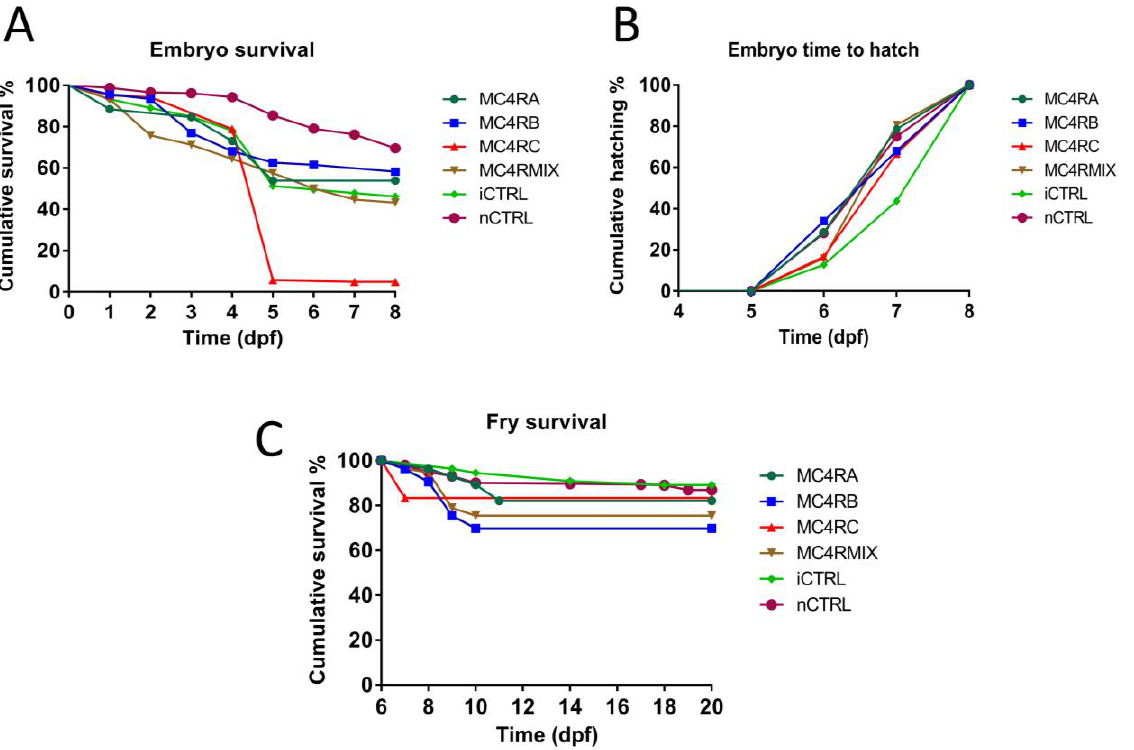
Figure 5. Embryo survival, hatchability, and fry survival curves of channel catfish, Ictalurus punctatus , embryos from the Kansas random strain microinjected at the one-cell stage with sgRNAs/Cas9 protein targeting the melanocortin-4 receptor ( mc4r ) gene. Three gRNAs were microinjected individually (MC4RA, MC4RB, and MC4RC) or multiplexed (MC4RMIX). Two control treatments were used. Injected control embryos (iCTRL) were full-sib to the treatment groups and injected with the same solution and volume, but without sgRNA or Cas9 protein. The second control was not injected (nCTRL). ( A ) Embryo cumulative survival was considered 100% at day 0 then decreased over time as embryos died. ( B ) The hatch rate was calculated as the fraction of embryos that hatched at a given time point compared to the total live embryos that hatched. ( C ) Fry survival was calculated for the fry just after hatching and until 20 days post fertilization